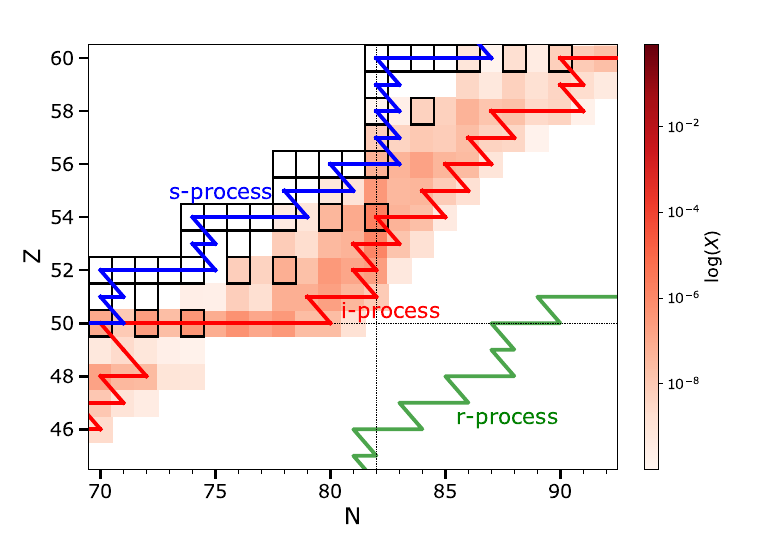
Figure 1. The main i-process path (red line) in a 1 M (cid:12) , [Fe / H] = − 2 . 3 , AGB model, at the bottom of the second thermal pulse , at the time of maximum neutron density ( N n = 2 . 2 × 10 15 cm − 3 ). The chemical abundances are shown by the red colour scale in mass fraction. The black squares are stable nuclei. Typical s- and r-process paths (in blue and green, respectively ) are shown for